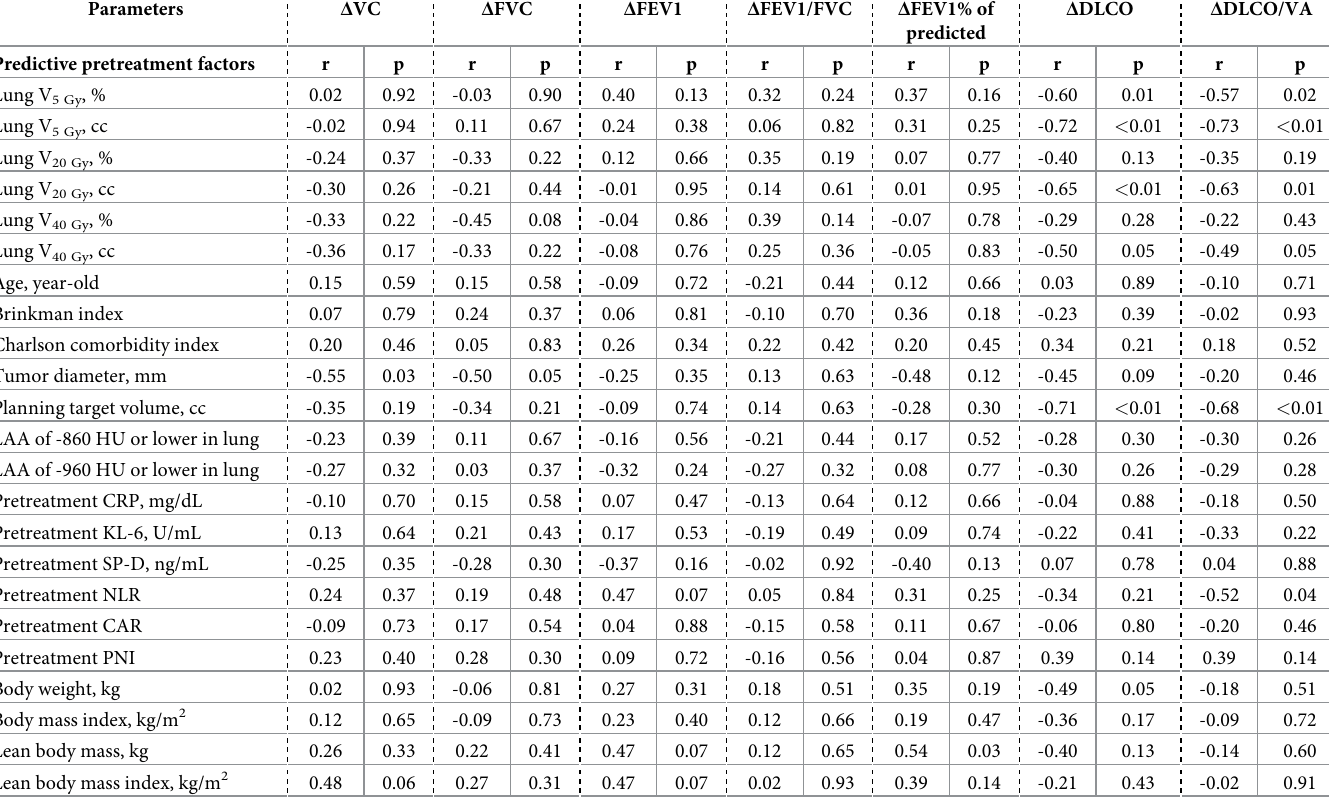
Table 4. Predictive factors of absolute changes in parameters of pulmonary function tests from baseline to 12 months after